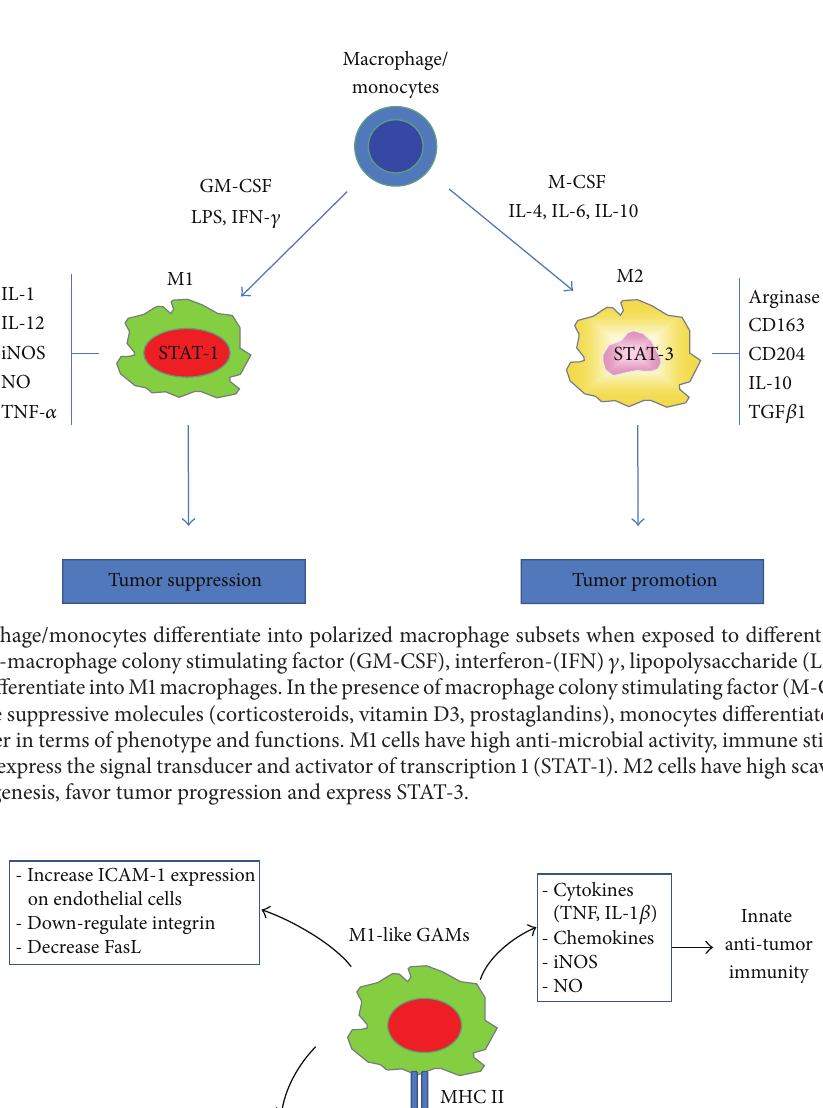
of proinflammatory cytokines in vitro [44]. IL-4, IL-6 and